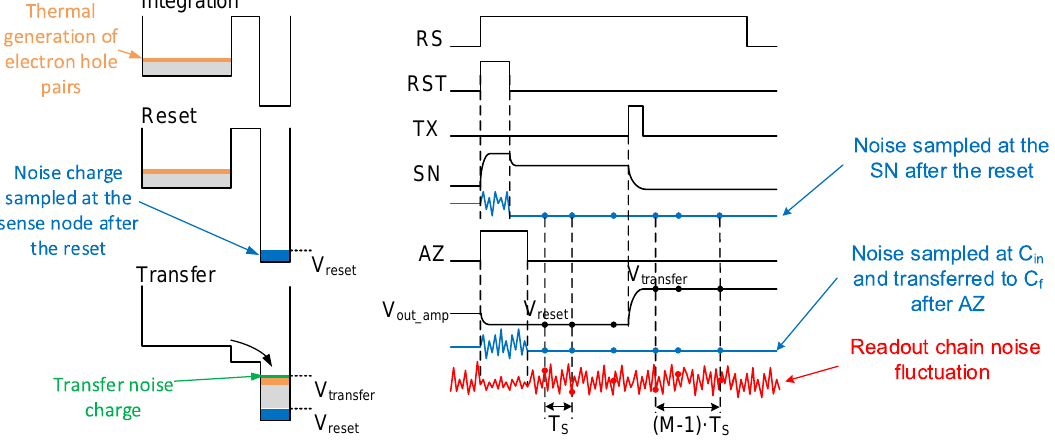
Figure 2. Timing diagram of the conventional CIS readout chain of Figure 1 with noise mechanisms affecting the signal at the PPD and the readout chain